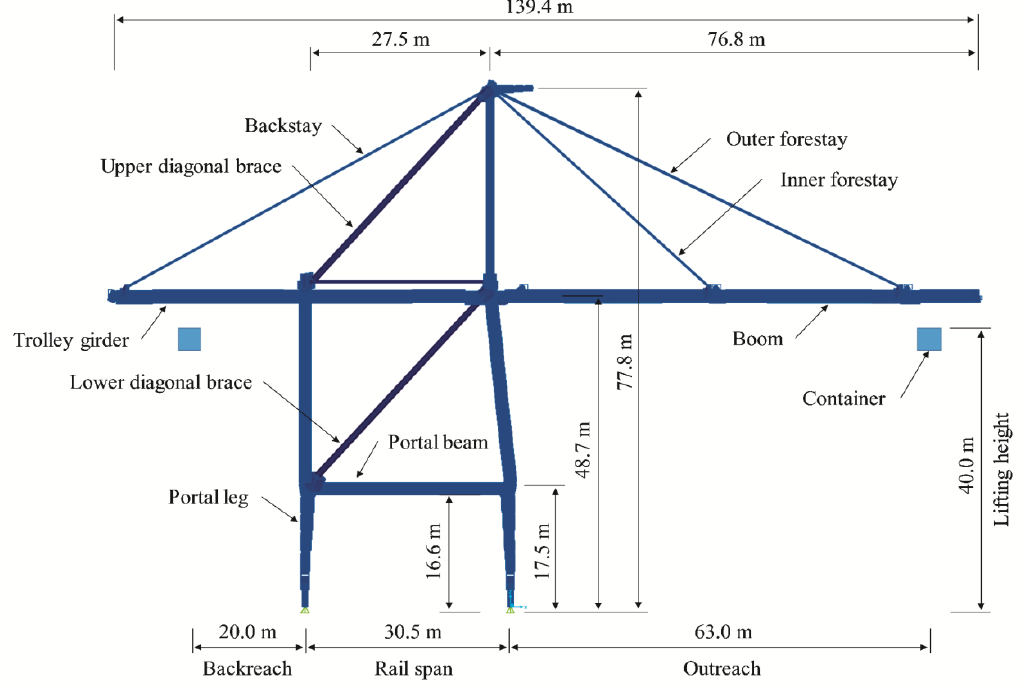
Figure 1. Overall dimensions of a Korean container crane.